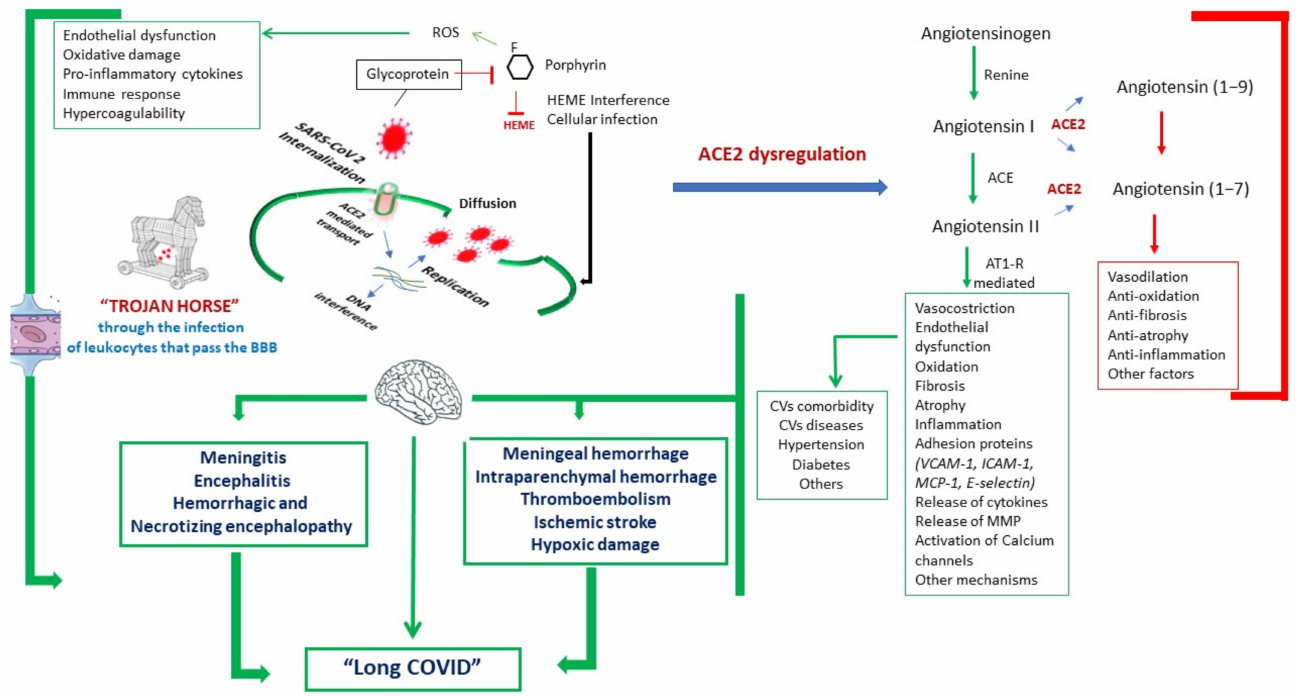
Figure 1. Main pathophysiological mechanisms proposed in patients with COronaVIrus Disease-19 (COVID-19) and related acute and long-term neurological manifestations. Angiotensin-converting enzyme-2 (ACE2) and iron chelated with any porphyrin, irrespective of the valence state of the iron atom (HEME) dysregulation, as well as direct action on vascular endothelium, immune response, and inflammation (with the subsequent release of inflammatory mediators), and the “Trojan horse hypothesis” (i.e., leukocytes-carriers of infection through the blood–brain barrier) have been proposed as the main mechanisms responsible for brain lesions. The inhibitory pathways are shown in red, while the activatory pathways are indicated in green, along with morphological changes responsible for cardiovascular and brain diseases, especially in comorbid patients. Legend: ACE2: angiotensin converting enzyme-2; AT1-R: angiotensin II receptor type; BBB: blood–brain barrier; CVs: cardiovascular manifestations; HEME: iron chelated with any porphyrin, irrespective of the valence state of the iron atom; ICAM-1: intercellular adhesion molecule 1; MCP-1: monocyte chemoattractant protein-1; MMP: matrix metalloproteinase; ROS: reactive oxygen species; VCAM-1: vascular cell adhesion molecule